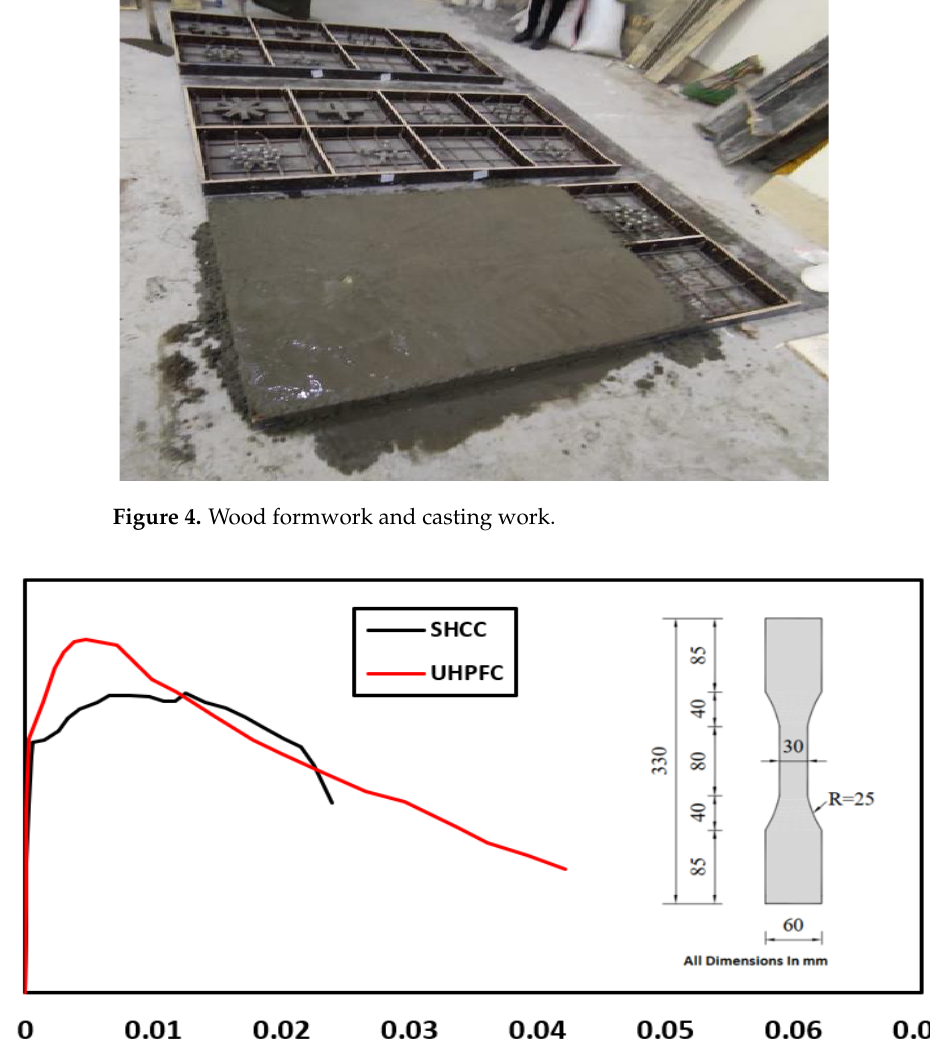
Figure 5. The geometry of the samples and tensile stress – strain curves.